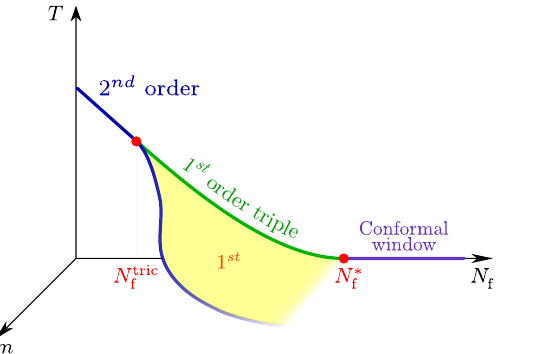
Figure 5. Schematic representation of a possible scenario for the T − m − N f phase diagram with different numbers of light mass-degenerate